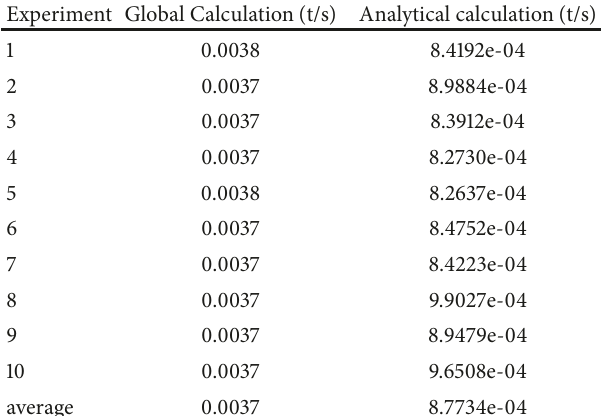
Figure 6: Results of path planning. Table 1: Comparison of calculation